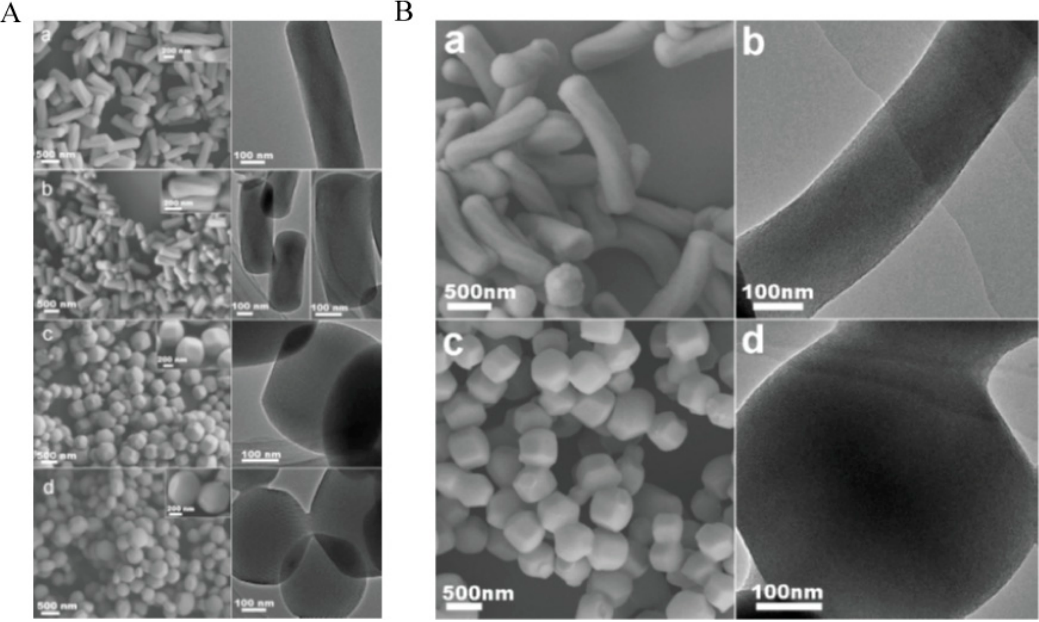
Figure 4. ( A ) SEM images (left), high-magnification SEM images (inset), and TEM images (right) for ( a ) CMS-20, ( b ) CMS-15, ( c ) CMS-10, and ( d ) CMS-5; ( B ): ( a , c ) SEM and ( b , d ) TEM images